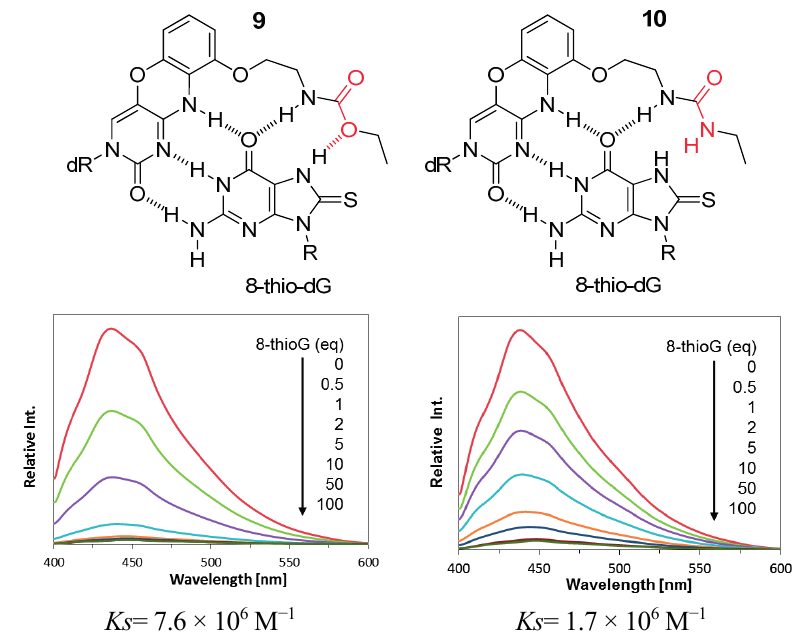
Figure 4. Proposed complexation of 8-thioG with the carbamate or the urea type. dR and R represent 3 ′ , 5 ′ -diOTBS-2 ′ -deoxyribosyl and triacetyl ribosyl groups,